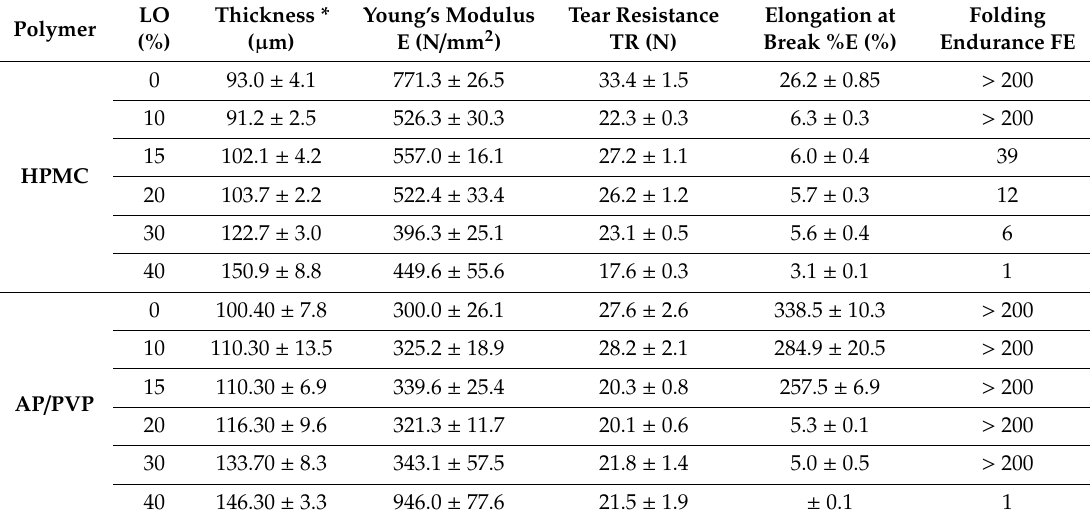
Table 2. Influence of solid particles loading (LO 0%–40%) on the mechanical properties of ODFs